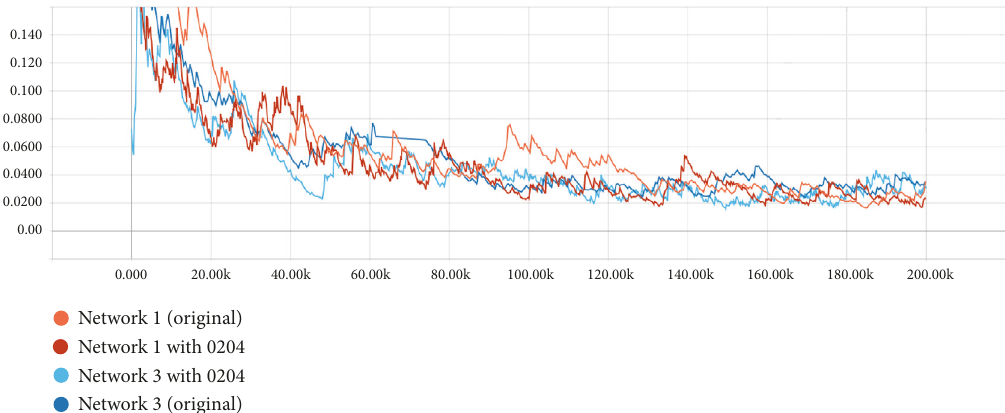
Figure 7: Comparison of original Networks 1 and 3 with respect to Network 2-04.